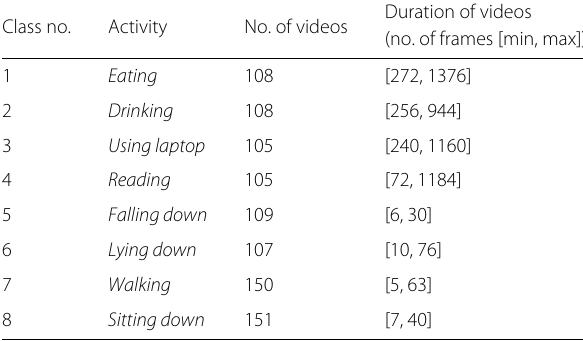
Table 1 Specifications on